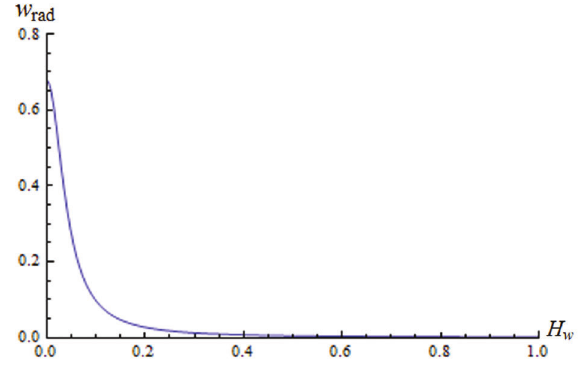
Figure 5. Representative illustration of the system frequency response for the standard diet